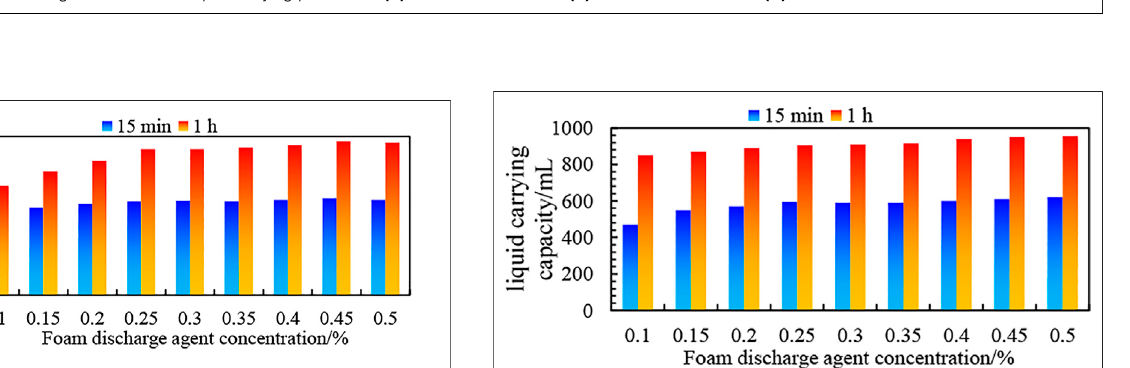
FIGURE 3 | Schematic diagram of the AES liquid carrying process at (A) 0.1% concentration. (B) 0.25% concentration. (C) 0.5% concentration.